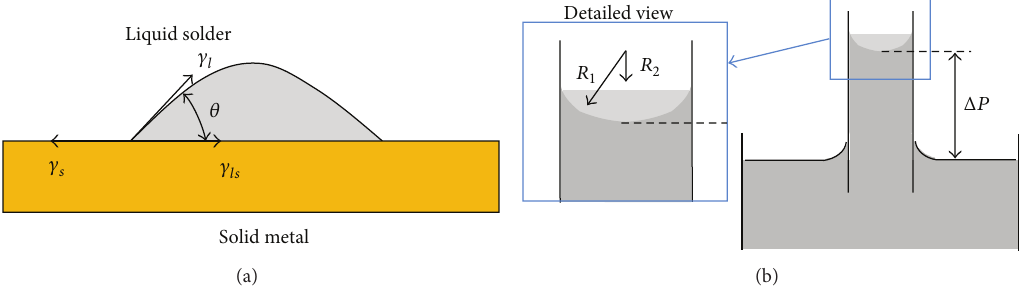
Figure 1: (a) Surface tension between solid surface and liquid solder and (b) capillary action of wave soldering.